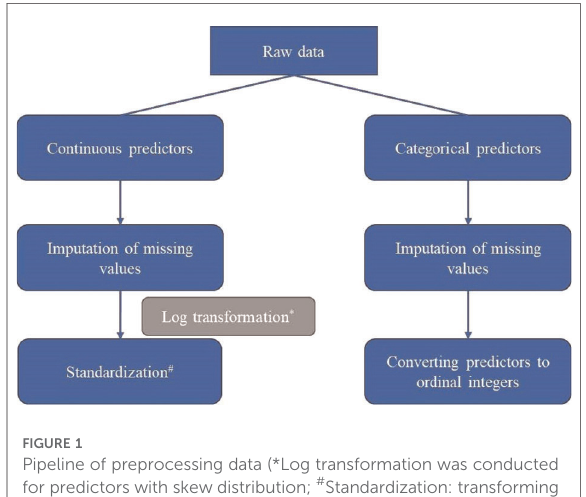
FIGURE 1 Pipeline of preprocessing data (*Log transformation was conducted for predictors with skew distribution; # Standardization: transforming data into normal transformation with zero mean and unit